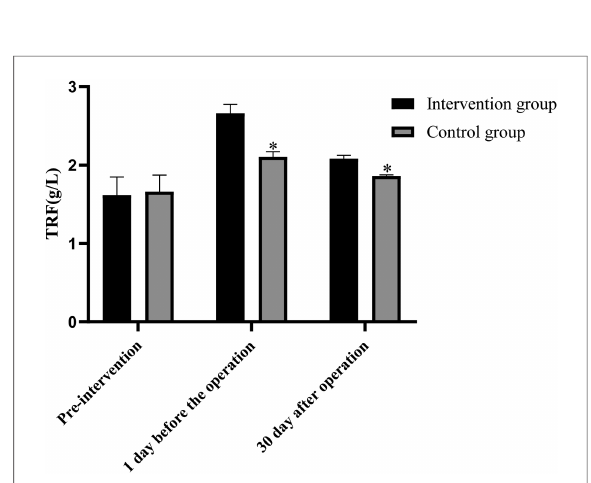
FIGURE 5 Comparison of TRF levels between the two groups before and after intervention (Note: compared with the intervention group, * P